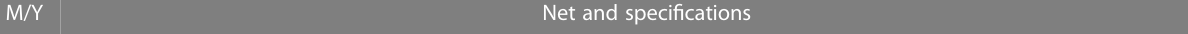
TABLE 1 Speci fi cations of hand-line and gillnet used for fi sh collection in the lagoon of Meiji Reef in the South China Sea. M/Y Net and speci fi cations 05/ Hand-line, hook with barb, size: 26.0 mm total length, 10.0 mm gape size, 1.0 mm thickness, 0.33 mm diameter nylon wire, # of lines: 9, working time: 3 h 1998 05/ Hand-line (same speci fi cations as May 1998), # of lines: 10, working time: 2 h; gillnet: 40 m length, 1.1 m height, 5.5 cm mesh size, 0.20 mm diameter nylon 1999 wire, # of sets: 26, working time: 2 h